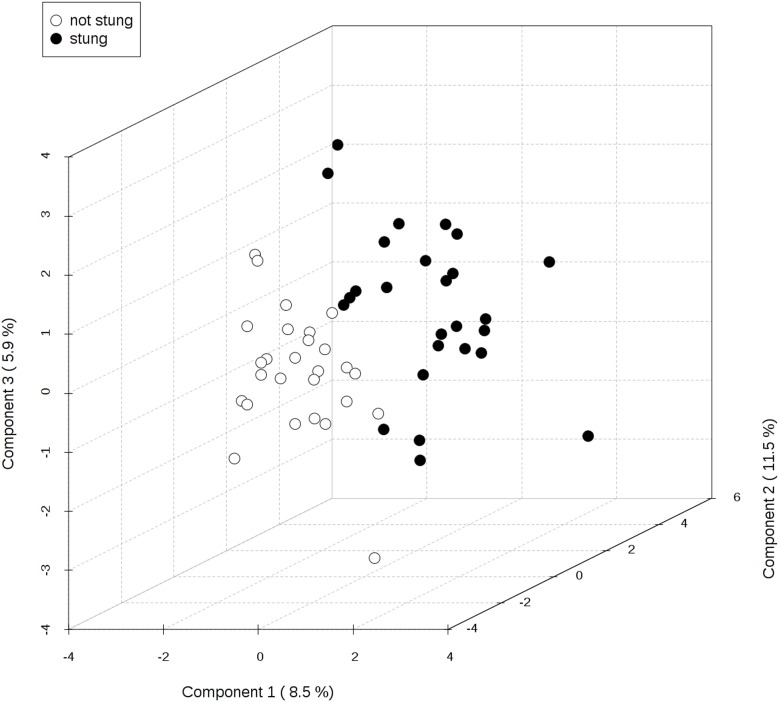
Three-dimensional (3D) partial least squares discriminant analysis separation using amino acids concentration-based metabolomics measurements in the serum of the beekeepers directly after a bee sting vs. the serum of the beekeepers after at least six weeks since the last sting (27 cases).The explained variances are shown in brackets.